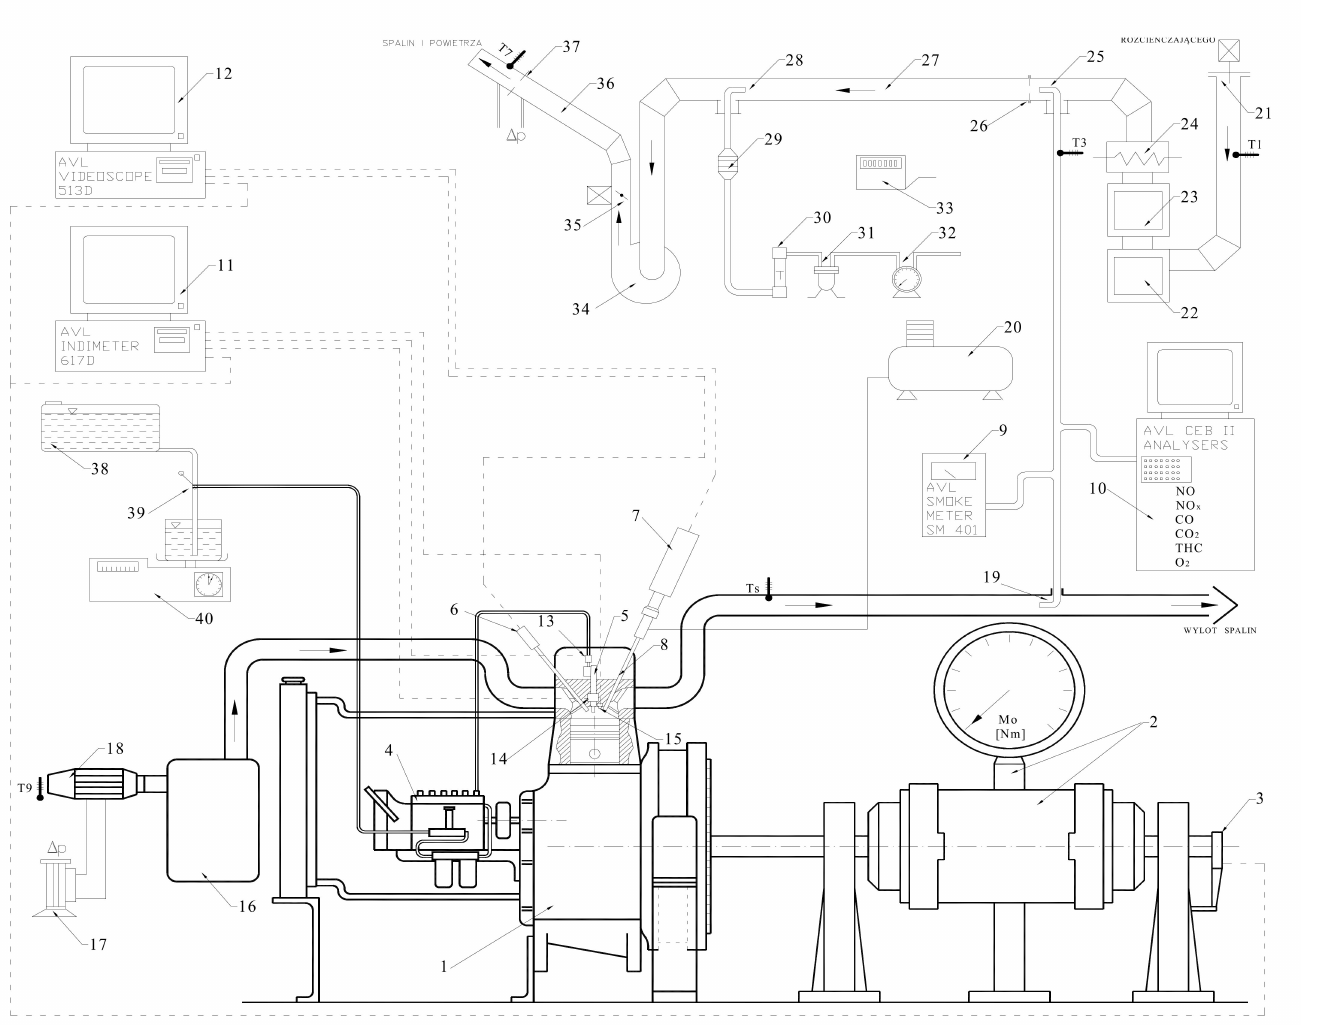
Figure 3. Diagram of test bench (detailed description of schematic element numbers can be found in the previous study